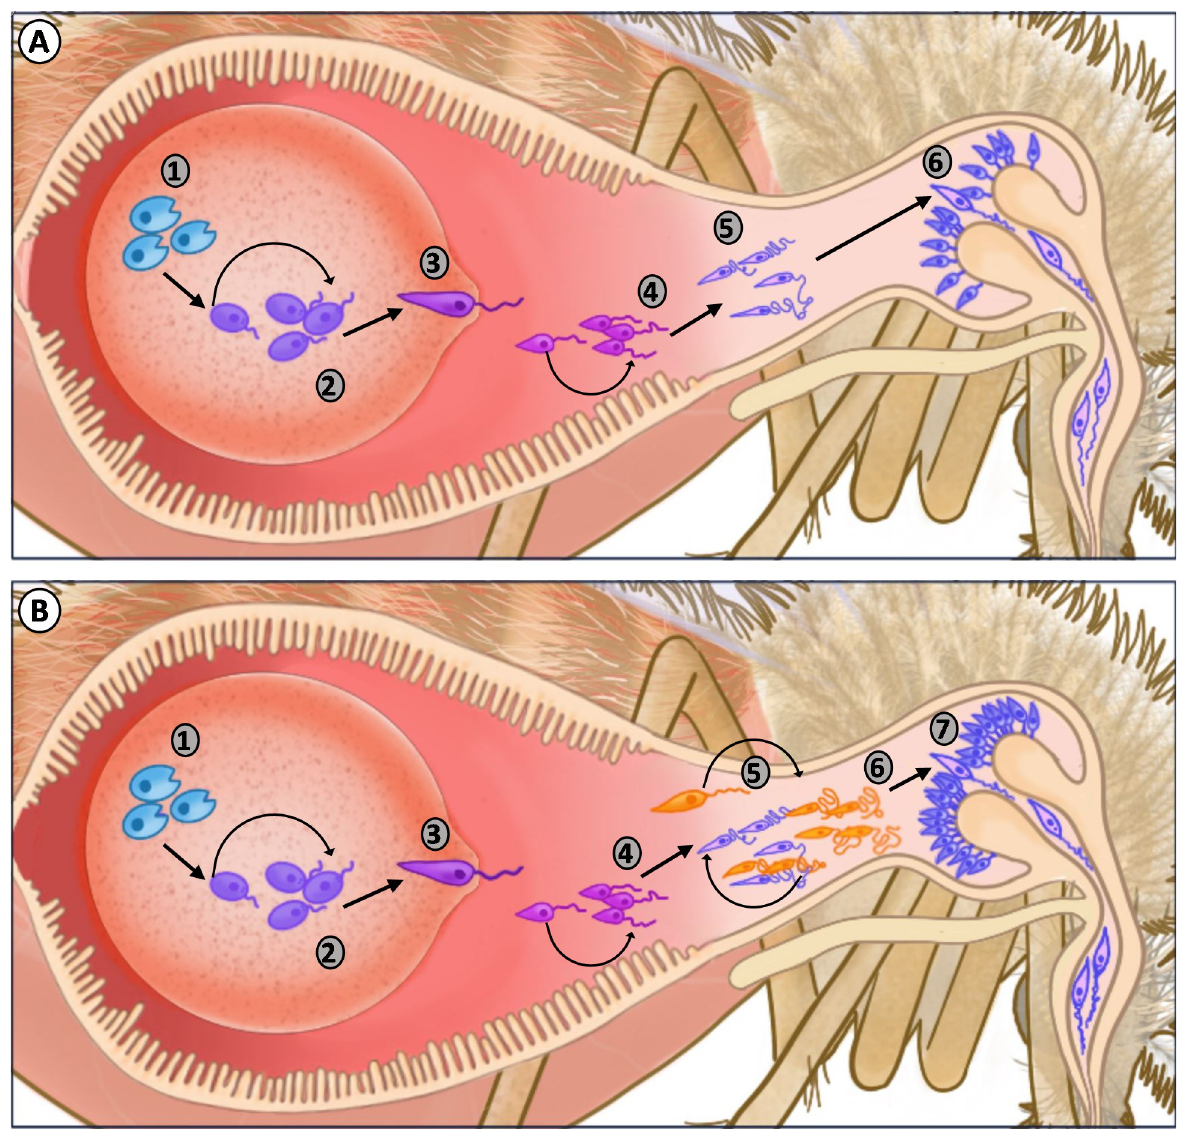
Fig 3. Multiple feeding by infected sandflies promotes Leishmania parasite differentiation, increasing the efficiency of transmission. (A) Depiction of Leishmania parasite development in a sandfly following a single blood meal under laboratory conditions. Immotile amastigotes (1) emerge from ingested macrophages and transform into the replicative procyclic promastigote form (2). Subsequently, replication slows, and the procyclic promastigotes transform into highly motile nectomonad promastigotes (3) and exit the peritrophic-encased blood bolus. Within the anterior portion of the midgut lumen, the parasites further develop into the replicative leptomonad promastigote form (4) and the (5) haptomonad promastigotes which attach the stomodeal valve. The leptomonads transform into infectious metacyclic promastigotes and migrate to the stomodeal valve where they can be regurgitated and transmitted during subsequent feeding events. (B) When sandflies with a mature infection take an additional blood meal, metacyclics undergo dedifferentiation into retroleptomonads (6), while earlier stages of parasite development (steps 1–5) have already matured. The production of retroleptomonads in response to an additional blood meal enables further parasite replication before differentiation back into metacyclic promastigotes, thus amplifying the number of infectious metacyclic (7) parasites that increase the potential for